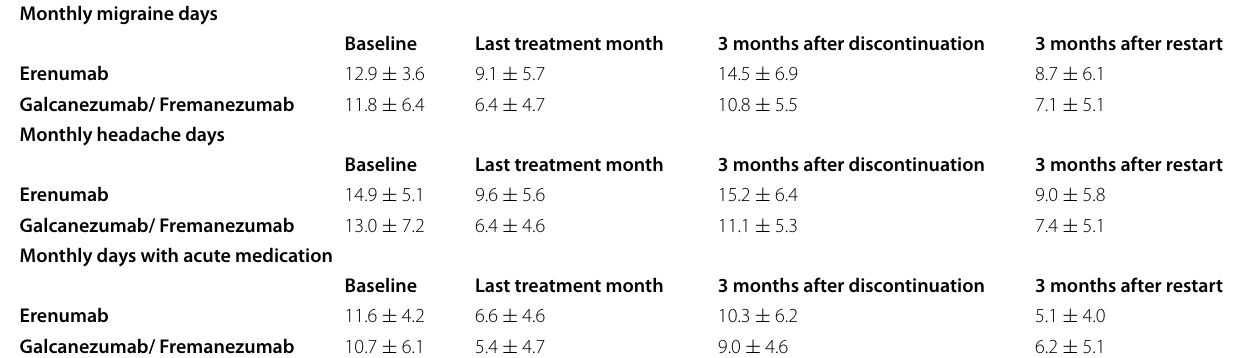
Table 2 Monthly migraine days, monthly headache days, and monthly days with acute medication use across the observation period in patients treated with the CGRP-R mAb erenumab and patients treated with the CGRP-mAbs galcanezumab or fremanezumab